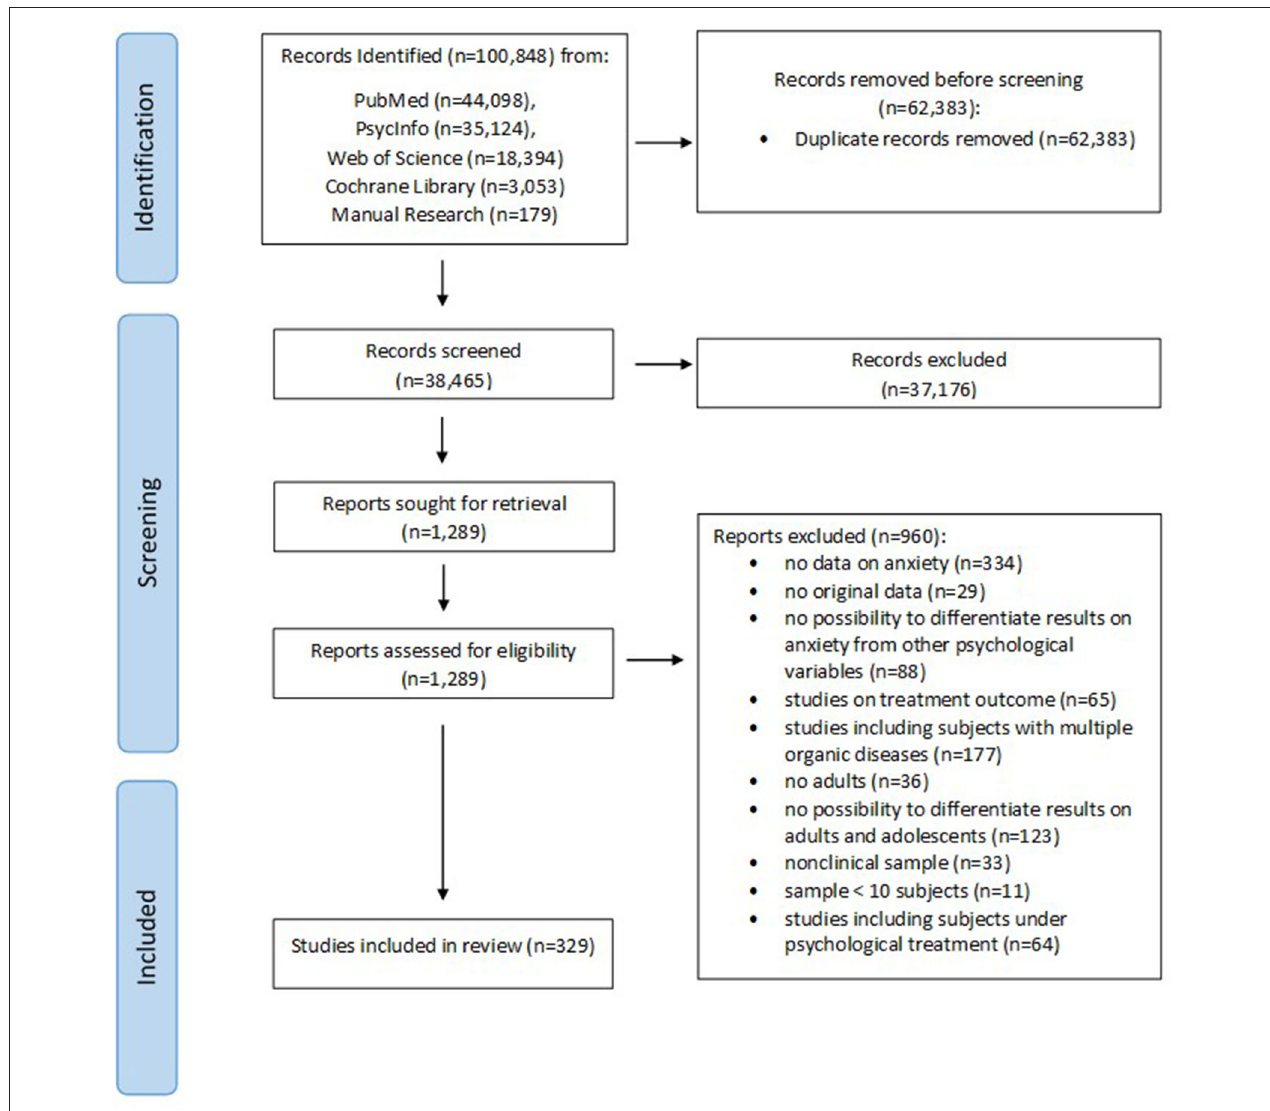
FIGURE 1 | Flow-chart of study